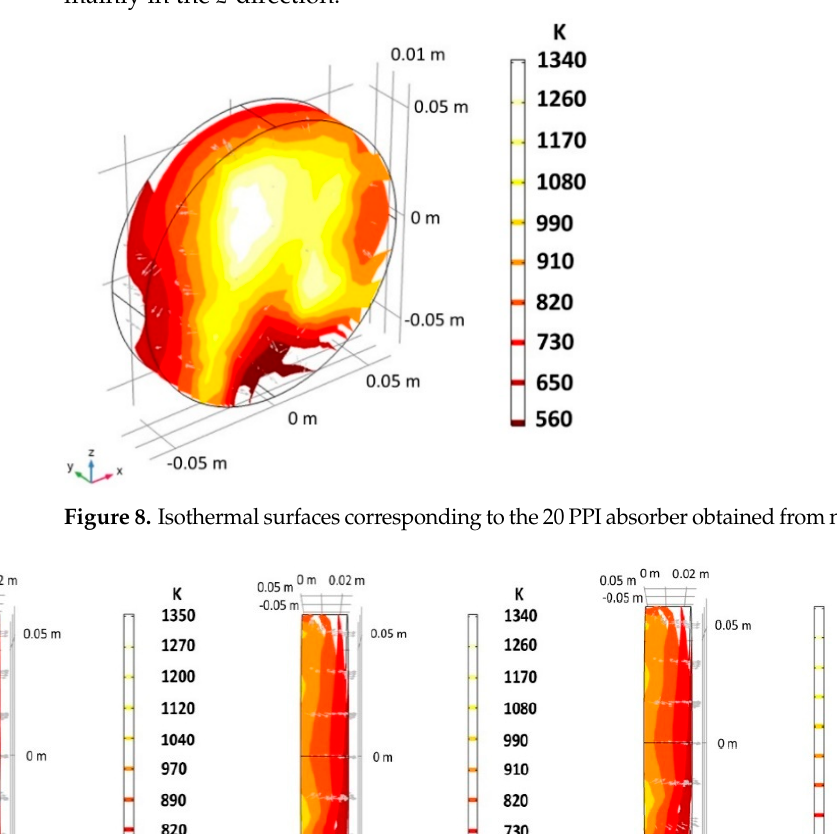
Table 1. Experimental (Exp) temperature data in the porous medium and simulations (Sim) pre- dictions for the 10, 20, and 30 PPI absorbers, with 30 L min − 1 in air flowrate. RMS refers to root-mean-square deviations.